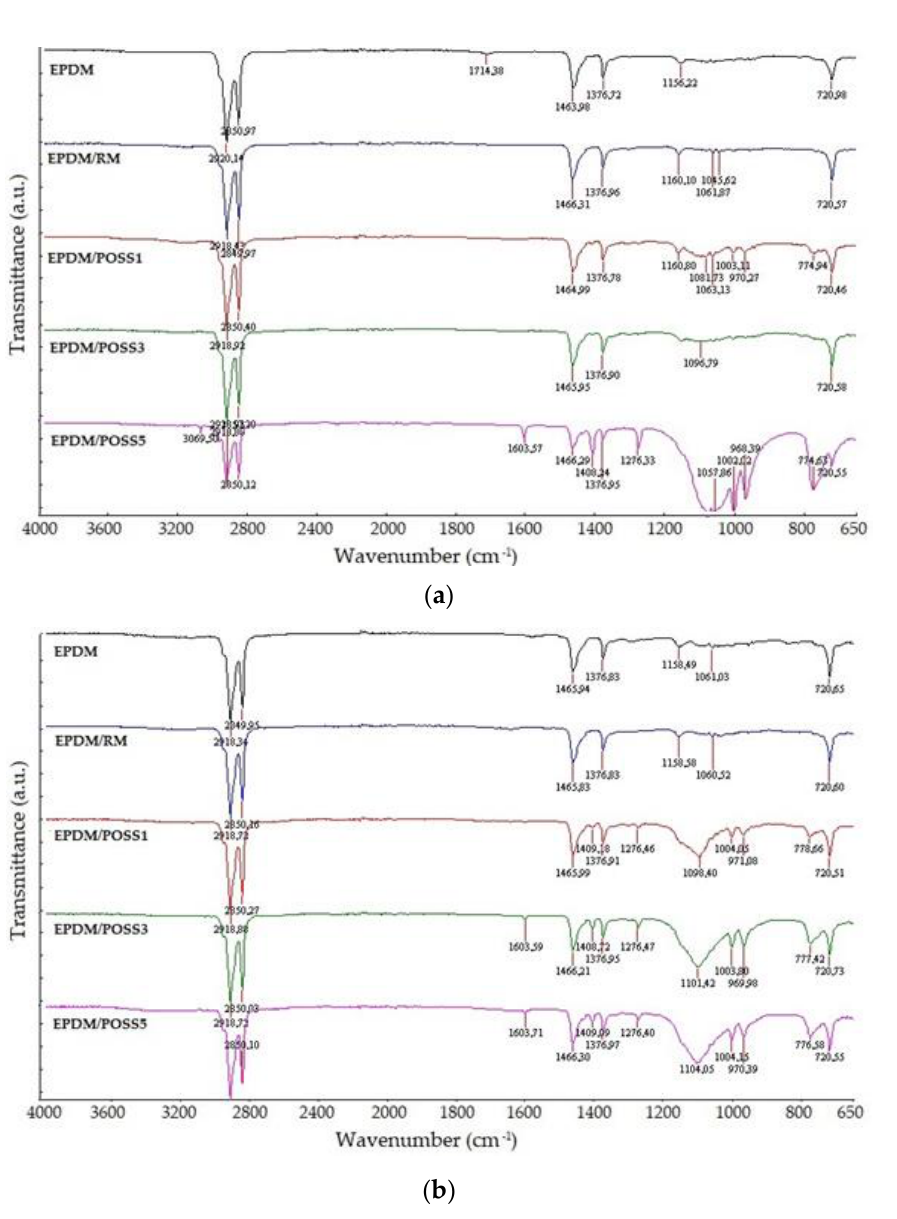
Table 1. Melting temperatures ( T m ), temperatures at 5% mass loss ( T 5% ) and residue % at 700 °C determined on EPDM composites.